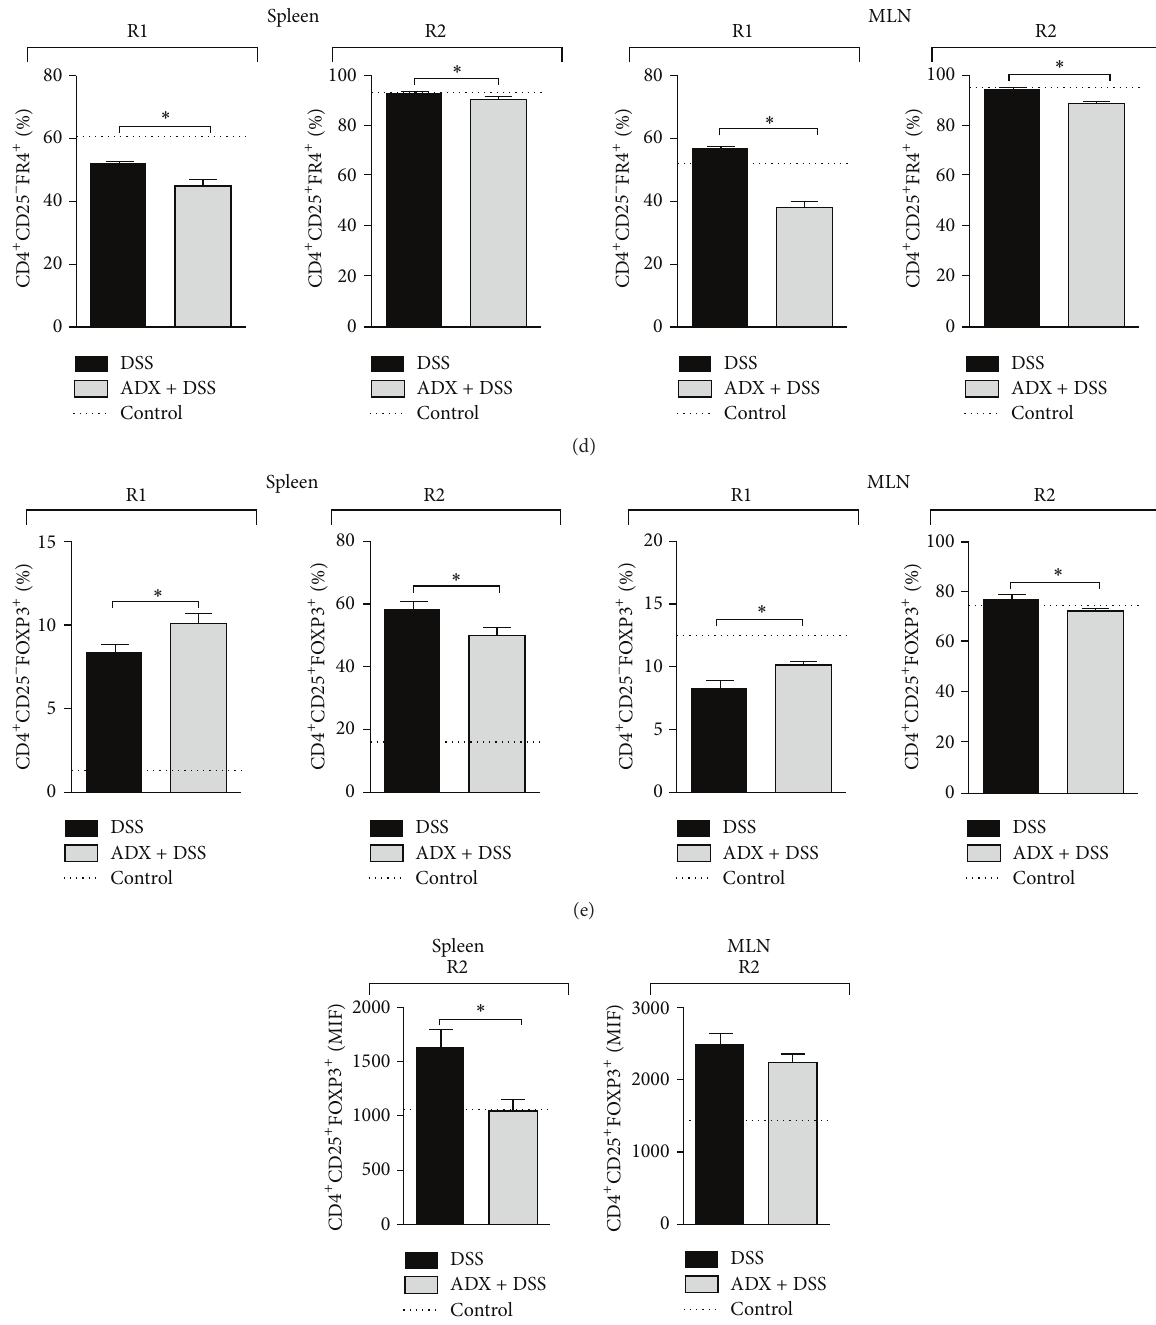
Figure 2: Reduced accumulation of regulatory T cells (Treg) in the absence of adrenal glands. C57BL/6 mice were adrenalectomized and exposed to dextran sulfate sodium (DSS) 3%. The spleen and MLN (mesenteric lymph nodes) were collected on the 6th day of colitis and processed for staining with specific antibodies for regulatory markers and flow cytometry. Analyses were performed according to the cell size (FSC) and granularity (SSC), followed by a selecting gate in the lymphocytes region and evaluation of dot plots for CD4 + CD25 + and CD4 + CD25 − cells (a), in which the frequency of Treg markers was quantified by histograms. (b) Percentage of CD4 + CD25 − PD1 + and CD4 + CD25 + PD1 + leukocytes from spleen and MLN. (c) Frequency of CD4 + CD25 − CD73 + and CD4 + CD25 + CD73 + cells from spleen and MLN. (d) Percentage of CD4 + CD25 − FR4 + and CD4 + CD25 + FR4 + leukocytes from spleen and MLN. (e) Frequency of CD4 + CD25 − FoxP3 + and CD4 + CD25 + FoxP3 + cells from spleen and MLN. (f) Mean fluorescence intensity (MFI) of FoxP3 in the CD4 + CD25 + population of spleen and MLN. DSS: C57BL/6 mice exposed to DSS; ADX + DSS: C57BL/6 adrenalectomized mice exposed to DSS. The dotted lines correspond to the control group without colitis. Results are representative of two independent experiments, with 5 mice/group. ∗ 𝑝 < 0.05